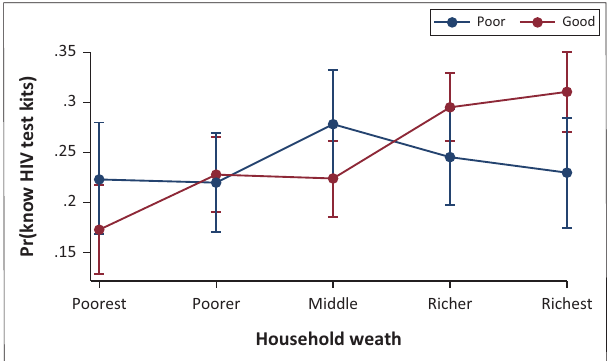
FIGURE 4: Predictive marginal effects of HIV test kits knowledge by employment status and HIV infection